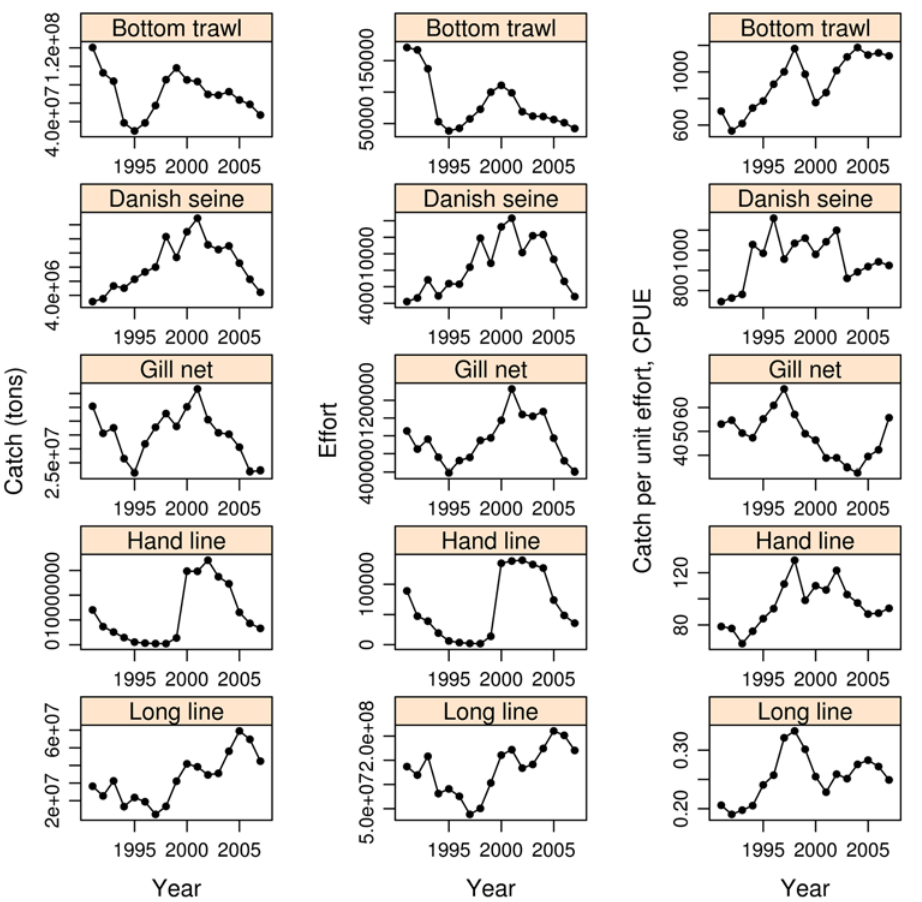
Figure 3. Catch (tons), effort and catch per unit effort, CPUE, at year for different gear. Data are from log book records. Parts of these data are the same as figures 9.3.1. and 9.3.2 in [62]. Units of effort for different gear are described in